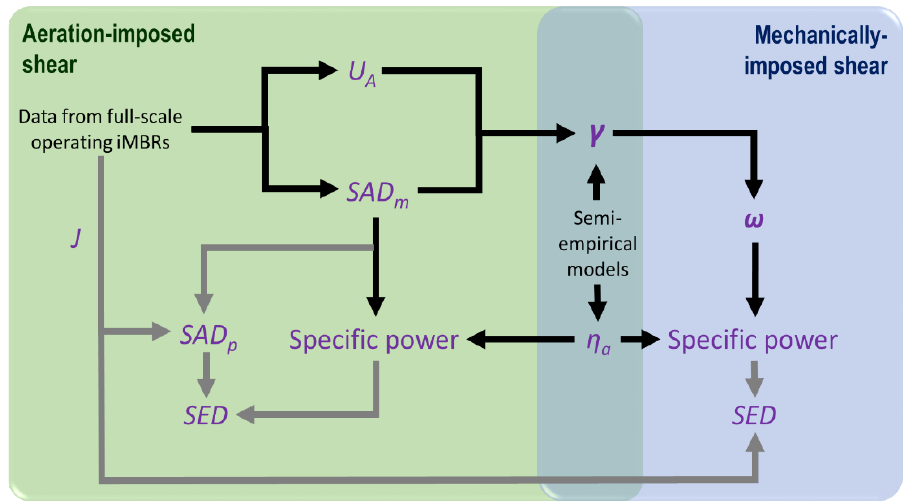
Figure 1. Determination of specific energy demand (SED) for mechanical-induced shear systems.